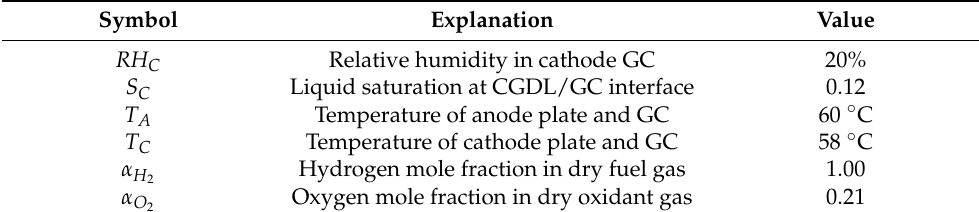
Table 3. Operation condition.